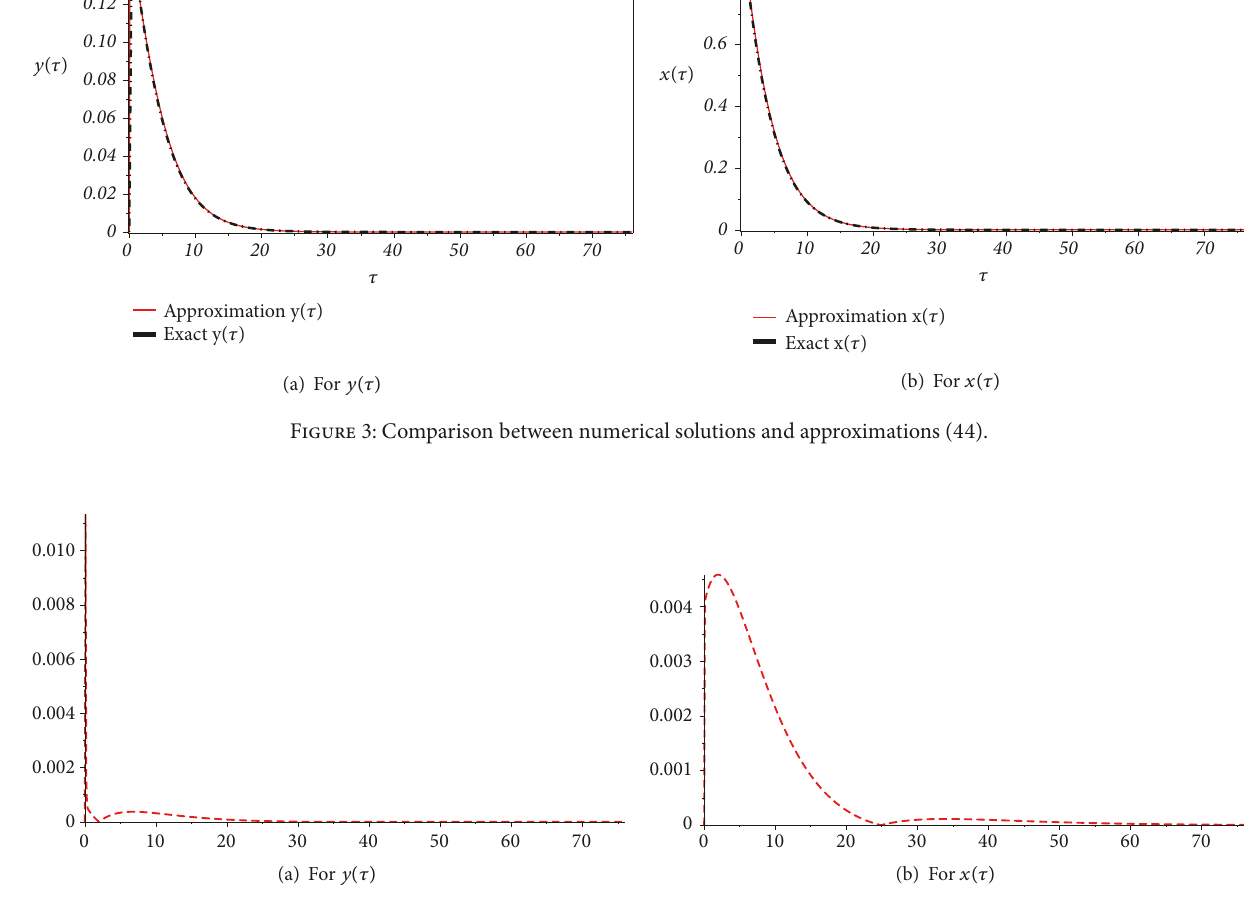
Figure 4: Absolute error for solutions